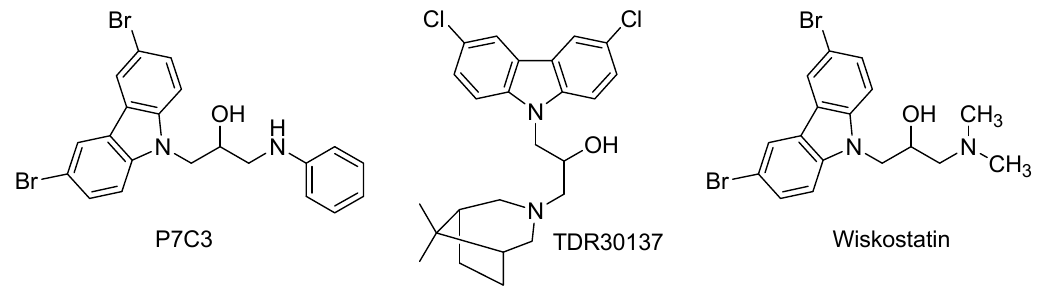
Figure 1. Structure of representative N -alkyl-3,6-dihalogencarbazole derivatives.